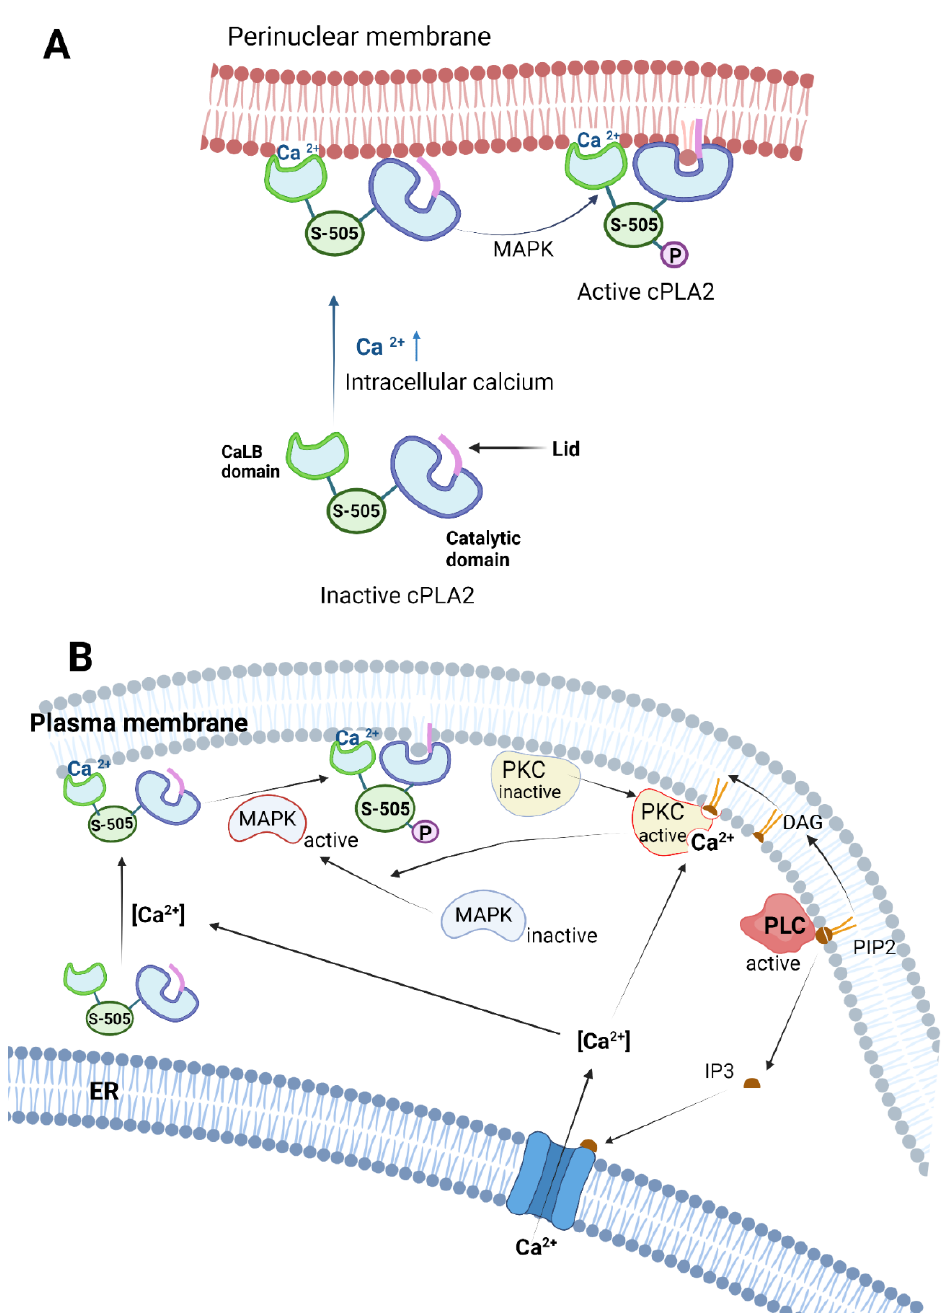
Figure 12. Multiple activation pathways for cPLA2 via calcium, phosphorylation and secondary messengers. ( A ) Ca 2+ ion helps in binding the CaLB domain of the cPLA2 with the membrane; however, the catalytic domain is not oriented in the right direction for hydrolyzing the phospholipid substrate. Phosphorylation in the flexible linker of the cPLA2 via MAPK induces optimal confor- mation of the catalytic domain, which facilitates partial penetration of the catalytic domain into the membrane. ( B ) The schematics for multiple regulation pathways for cPLA2. PIP2 is hydrolyzed by PLC to form secondary messengers such as IP3 and DAG. IP3 opens up the Ca 2+ ion channel in the perinuclear membrane of the ER, which increases the intracellular Ca 2+ concentration. The DAG and the Ca 2+ simultaneously activates PKC, which subsequently activates MAPK. The activated MAPK phosphorylates the cPLA2, which further enhances the cPLA2 activity. Created with